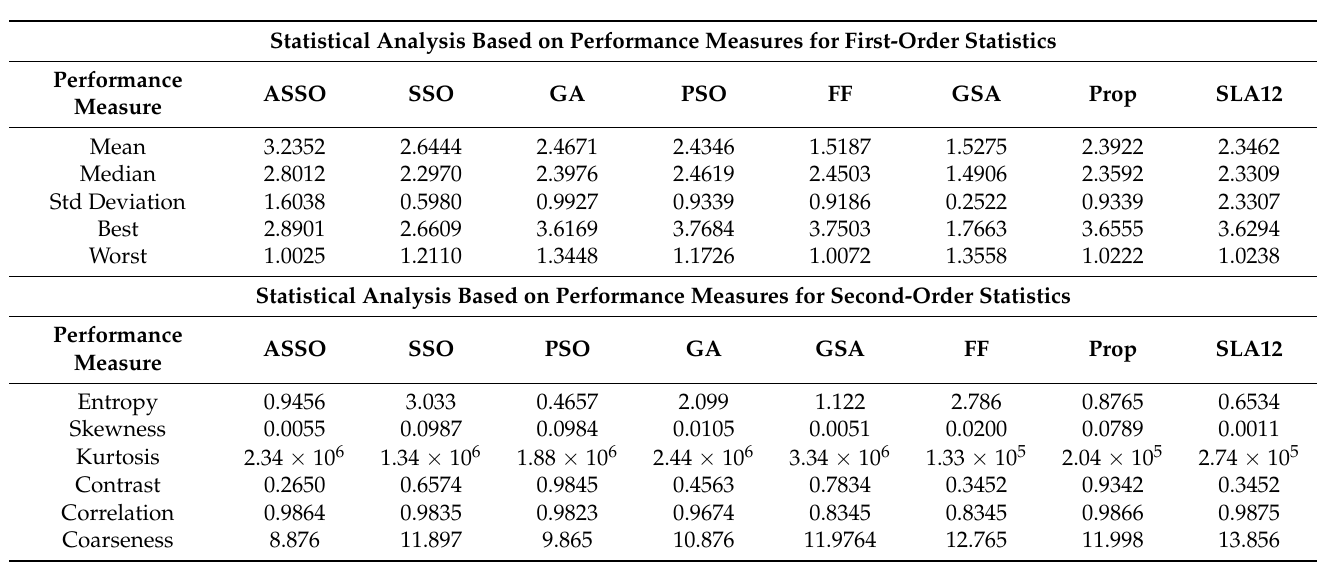
Table 7. First-order and second-order statistical analysis based on performance measure.